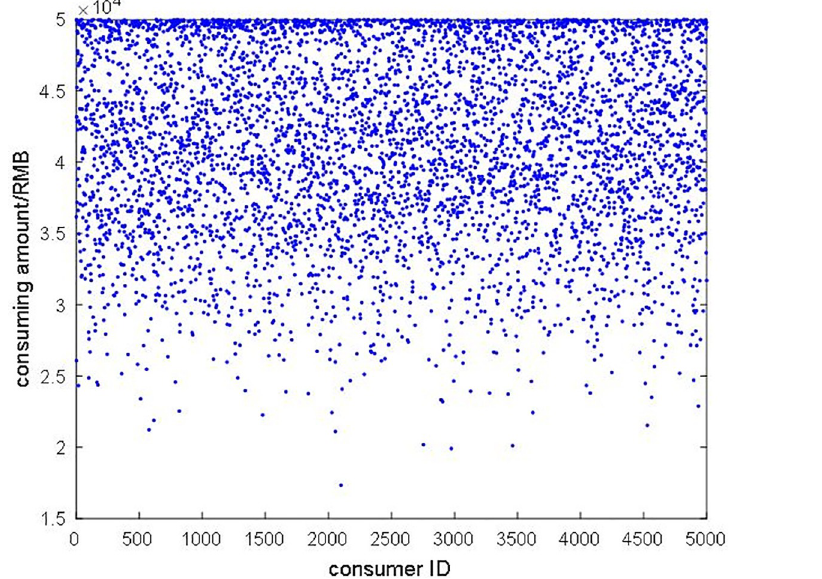
Fig 10. The personal consumption amount after